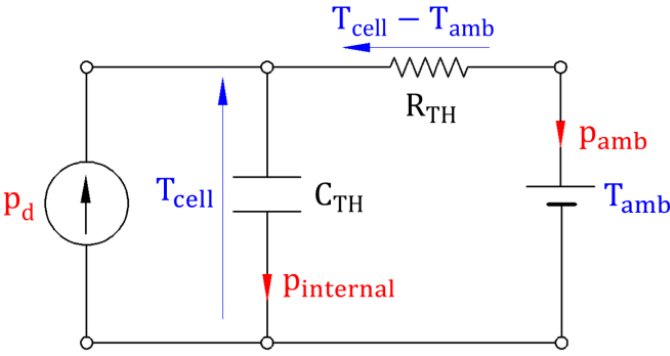
Figure 3. Upper Incomplete Gamma Function for different values of a.